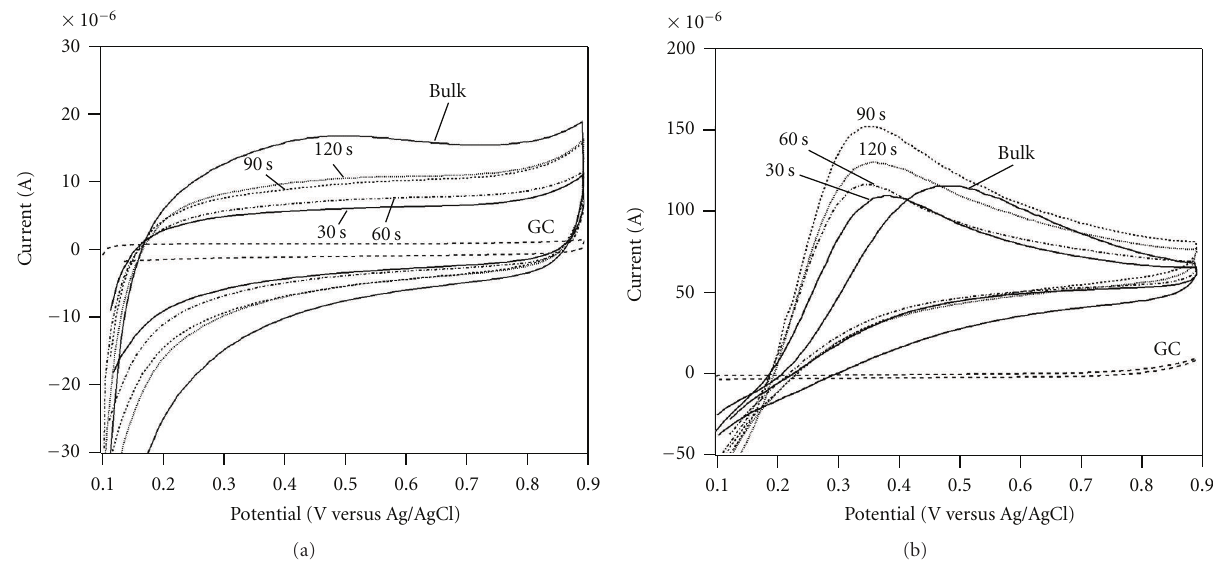
Figure 5: CVs of GC, ULPt(30s–120s), and bulk Pt in 1/15 M phosphate bu ff er solution without (a) and with (b) 1mM hydrogen peroxide. The potential of the WE was scanned from 0.1 to 0.9V versus Ag/AgCl with the sweep rate of 50